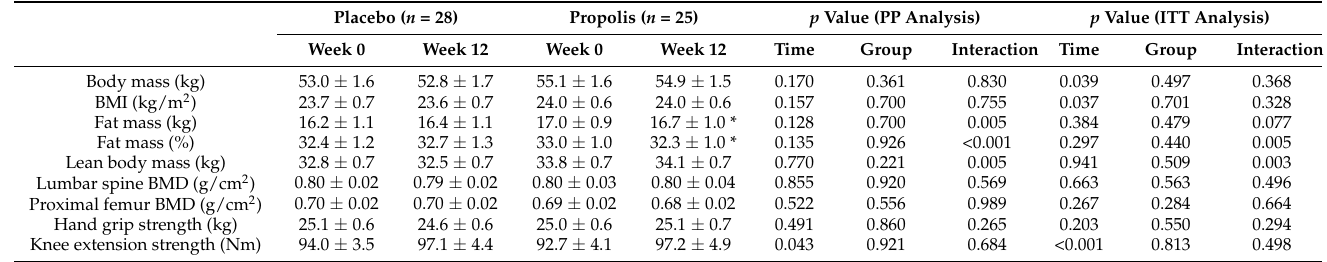
Table 2. Measurements before and after 12 weeks of supplementation with propolis and placebo Data are presented as mean ± standard error of the mean. Results from both ITT and PP analysis are shown. Variables were analyzed via two-factor repeated-measures analysis of variance, with time (week 0 vs. 12) and group (placebo vs. propolis) as factors. A p value of <0.05 was considered statistically significant. For variables with a significant time × group interaction, post hoc analyses with Bonferroni correction were conducted to identify significant within-group effects. * Significantly different from before the intervention. PP, per-protocol; ITT, intention-to-treat; BMI, body mass index; BMD, bone mineral density.